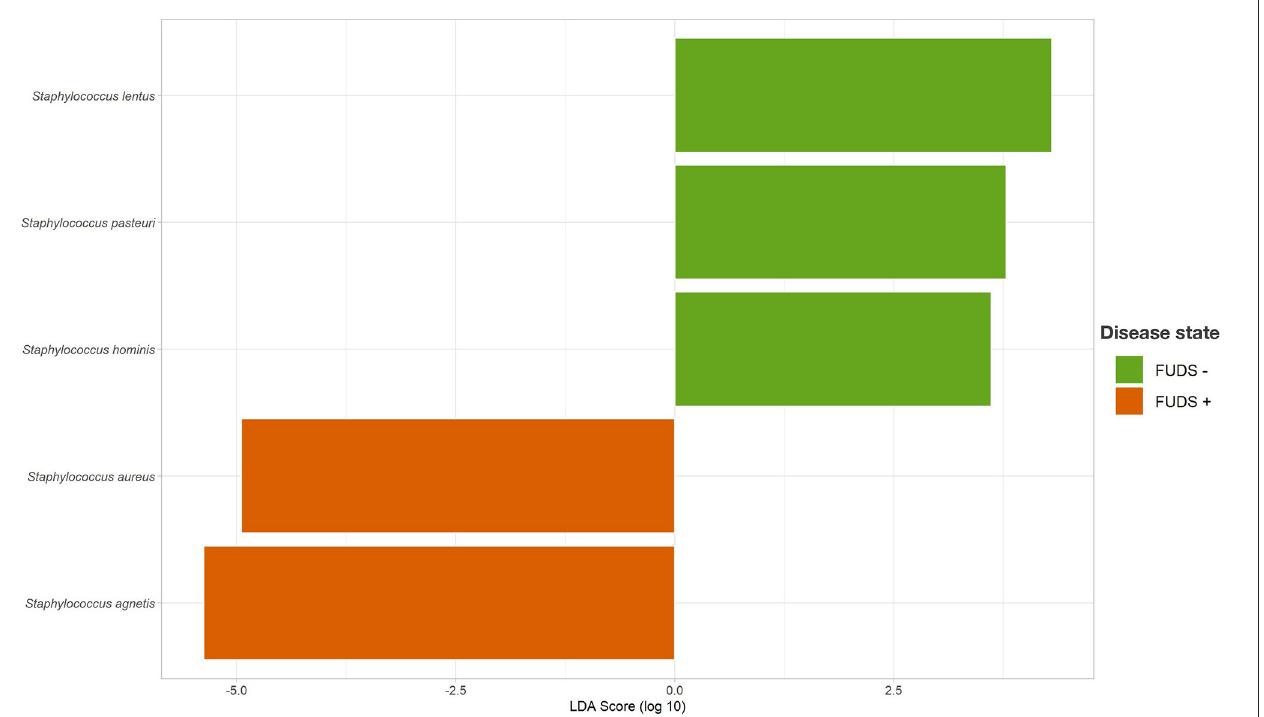
FIGURE7 Linear discriminant analysis (LDA) effect size (LEfSe) for Staphylococcus differential abundance between FUDS + and